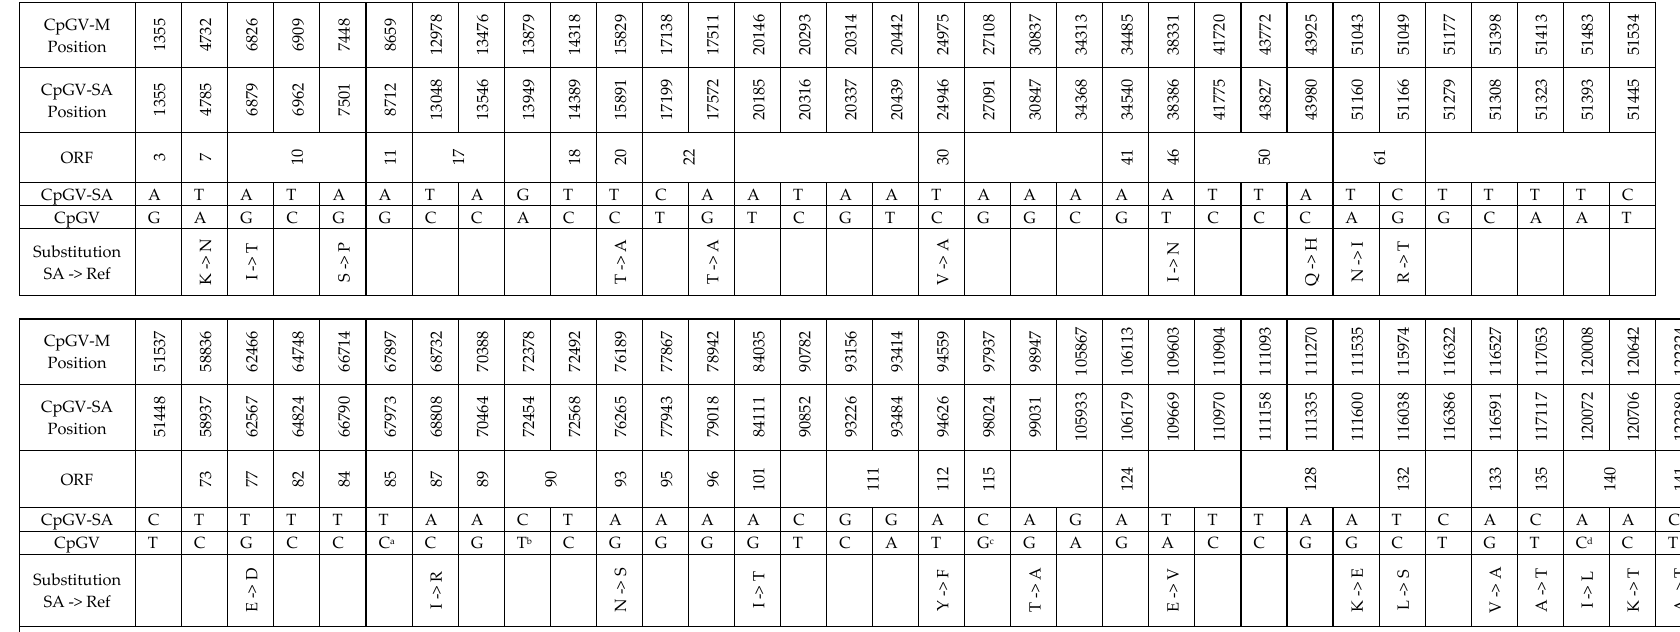
Table 1. Alignment of 67 novel SNPs identified between CpGV-SA and CpGV-E2, -I07, -I12, -M, and –S, grouped as CpGV. Positions for each nucleotide are given relative to the CpGV-M and CpGV-SA sequences. The corresponding ORF numbers are provided above the alignment for SNPs occurring within coding regions while any resulting amino acid substitutions are shown below. Nucleotides: A = Adenine, C = Cytosine, G = Guanine, T = Thymine; Ambiguous nucleotides: Y = C or T and M = A or C and amino acids: A = Alanine, R = Arginine, N = Asparagine, Q = Glutamine, H = Histidine, I = Isoleucine, K = Lysine, P = Proline, S = Serine, T = Threonine, and V = Valine. CpGV-M Position